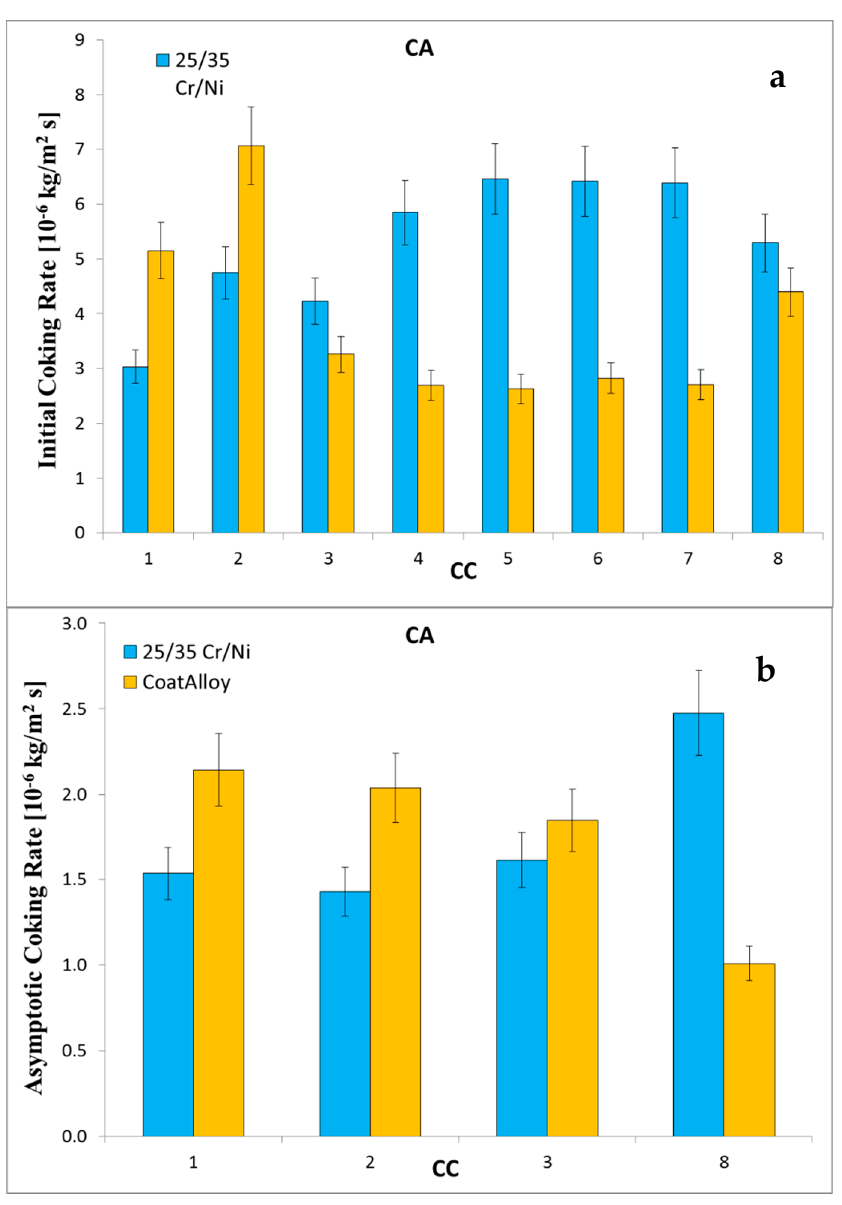
Figure 5. Initial ( a ) and asymptotic ( b ) coking rates of CA experiments .